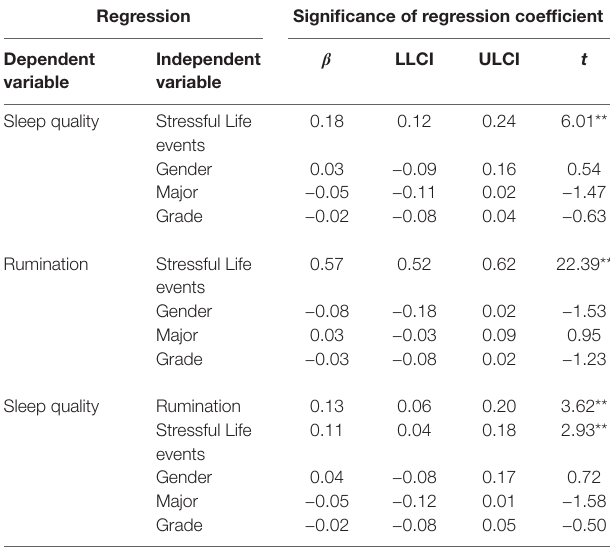
TABLE 2 | Multiple regression analyses of the indirect effect of